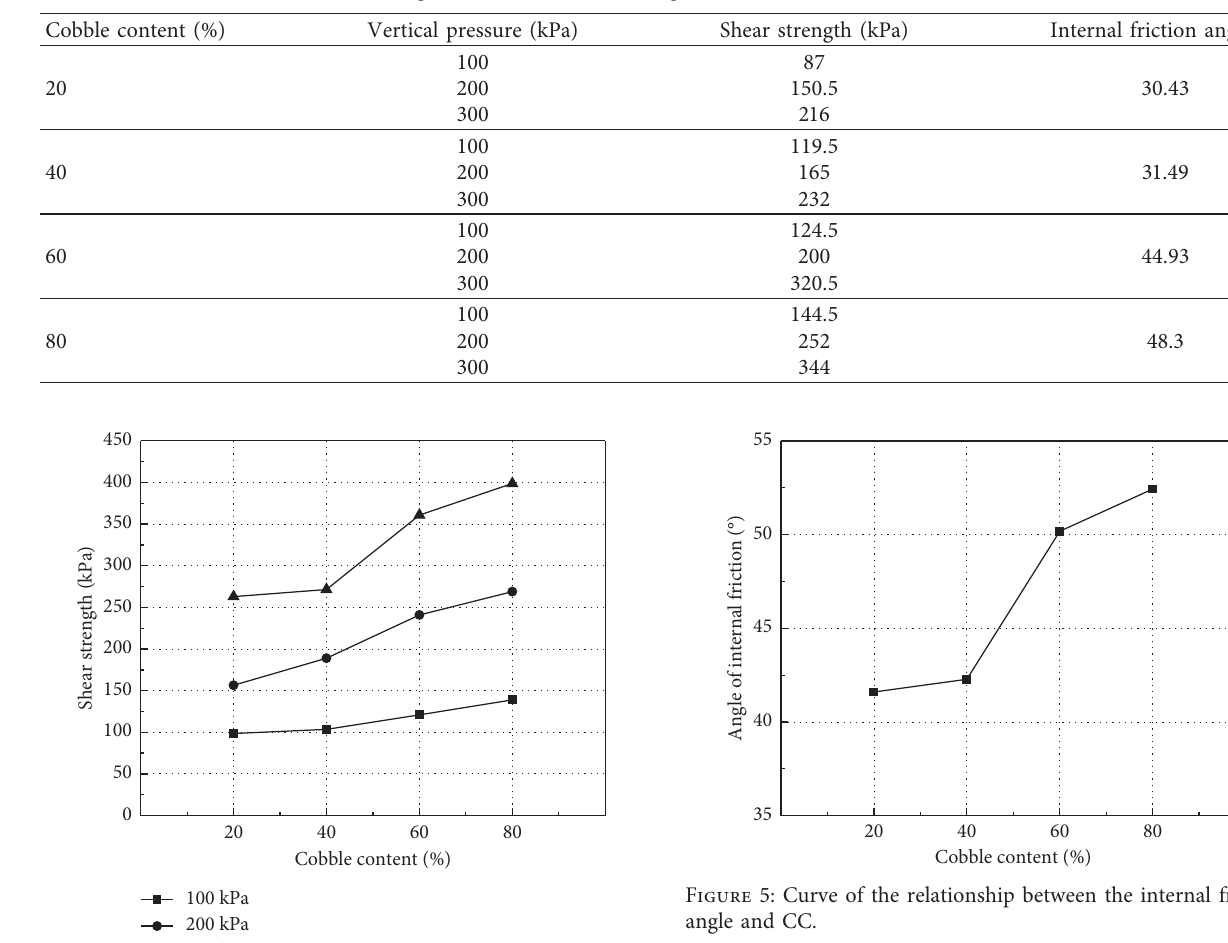
Table 1: Shear strength and internal friction angle of sand and cobble soil with different CCs.